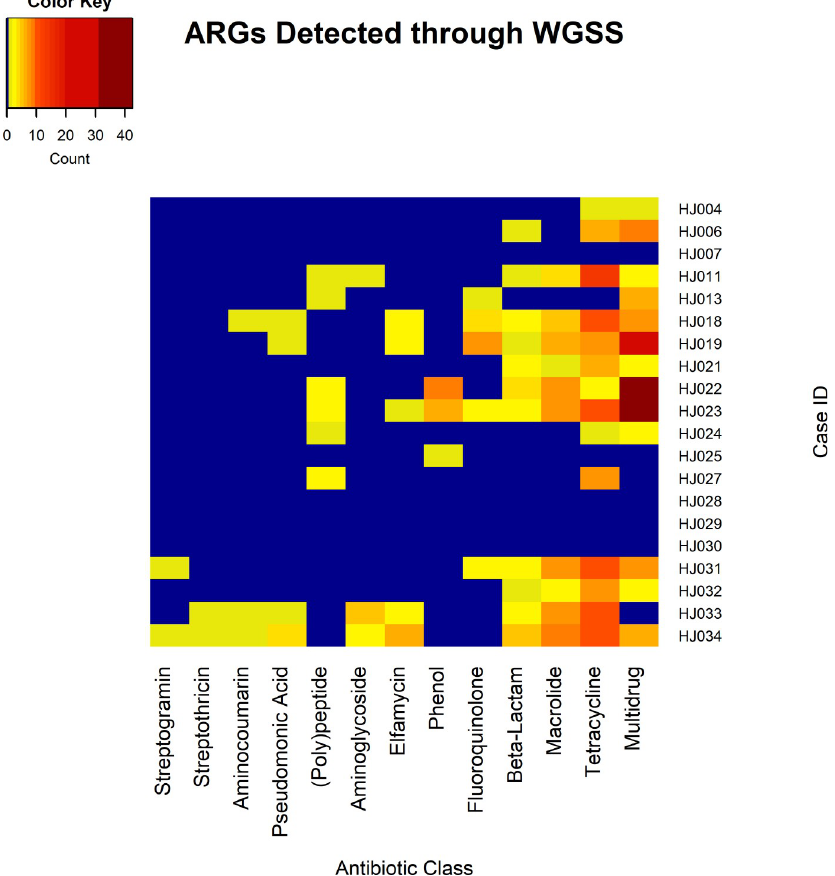
Fig 3. Heatmap visualization of ARGs identified from each case’s metagenome. Resistance genes to streptogramins, streptothricins, aminocoumarins, pseudomonic acids, (poly)peptides, aminoglycosides, elfamycins, phenols, fluoroquinolones, beta-lactams, macrolides, tetracyclines, and multidrug efflux pumps were identified. The color and numbers represent the range of genes found to inhibit antibiotic classes. Blue indicates no detection and red the highest